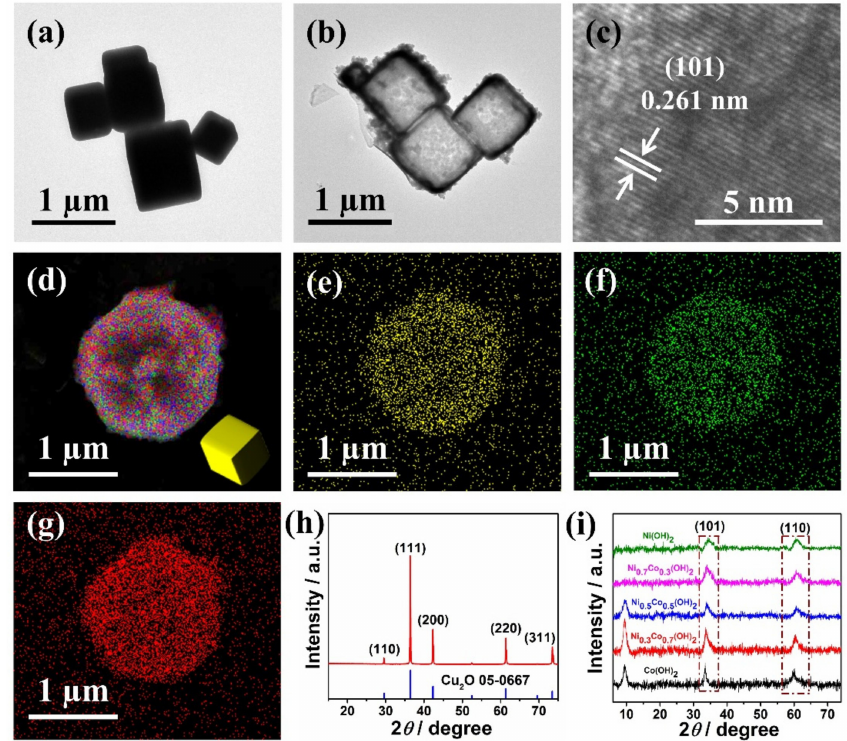
Figure 2. Transmission electron microscopy (TEM) images of ( a ) Cu 2 O and ( b ) Ni 0.7 Co 0.3 (OH) 2 hollow cubes. ( c ) High-resolution transmission electron microscope (HRTEM) image of Ni 0.7 Co 0.3 (OH) 2 . ( d – g ) EDS mapping of Ni 0.7 Co 0.3 (OH) 2 hollow cubes. The X-ray di ff raction (XRD) patterns of ( h ) Cu 2 O and ( i ) Ni 0.7 Co 0.3 (OH) 2 hollow cubes with di ff erent Ni-Co